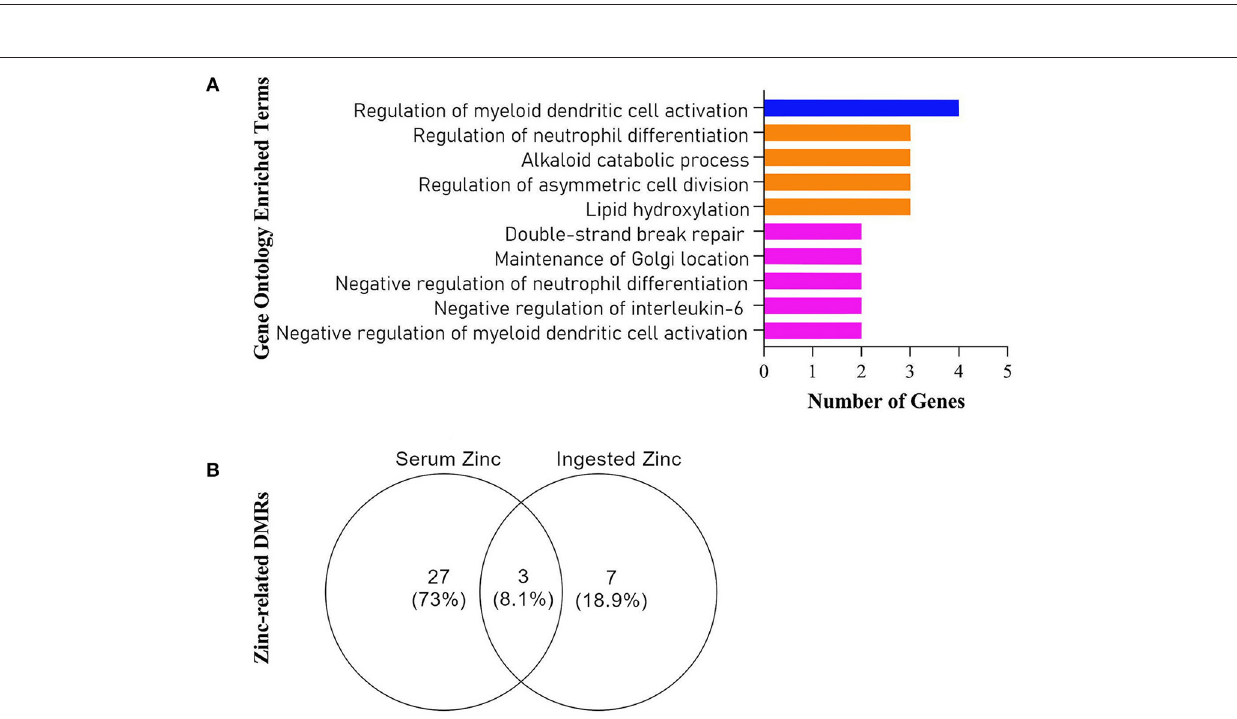
Frontiers in Nutrition |